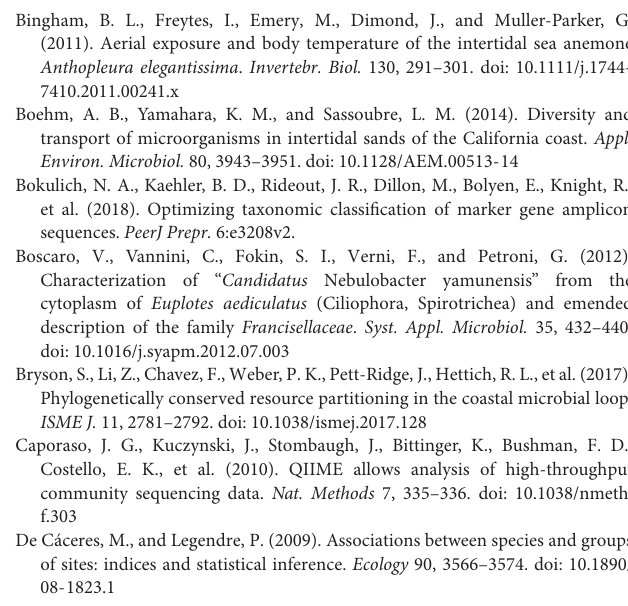
FIGURE S1 | Taxonomic composition of OTUs identified as contaminants. DATA SHEET S1 | Metadata, including site, latitude, symbiotic state, sequencing depth, and alpha diversity metrics for each sample. DATA SHEET S2 | Orders core to the microbiome of A. elegantissima . DATA SHEET S3 | Taxa found to be indicators of symbiotic state. DATA SHEET S4 | Orders with abundances correlating with